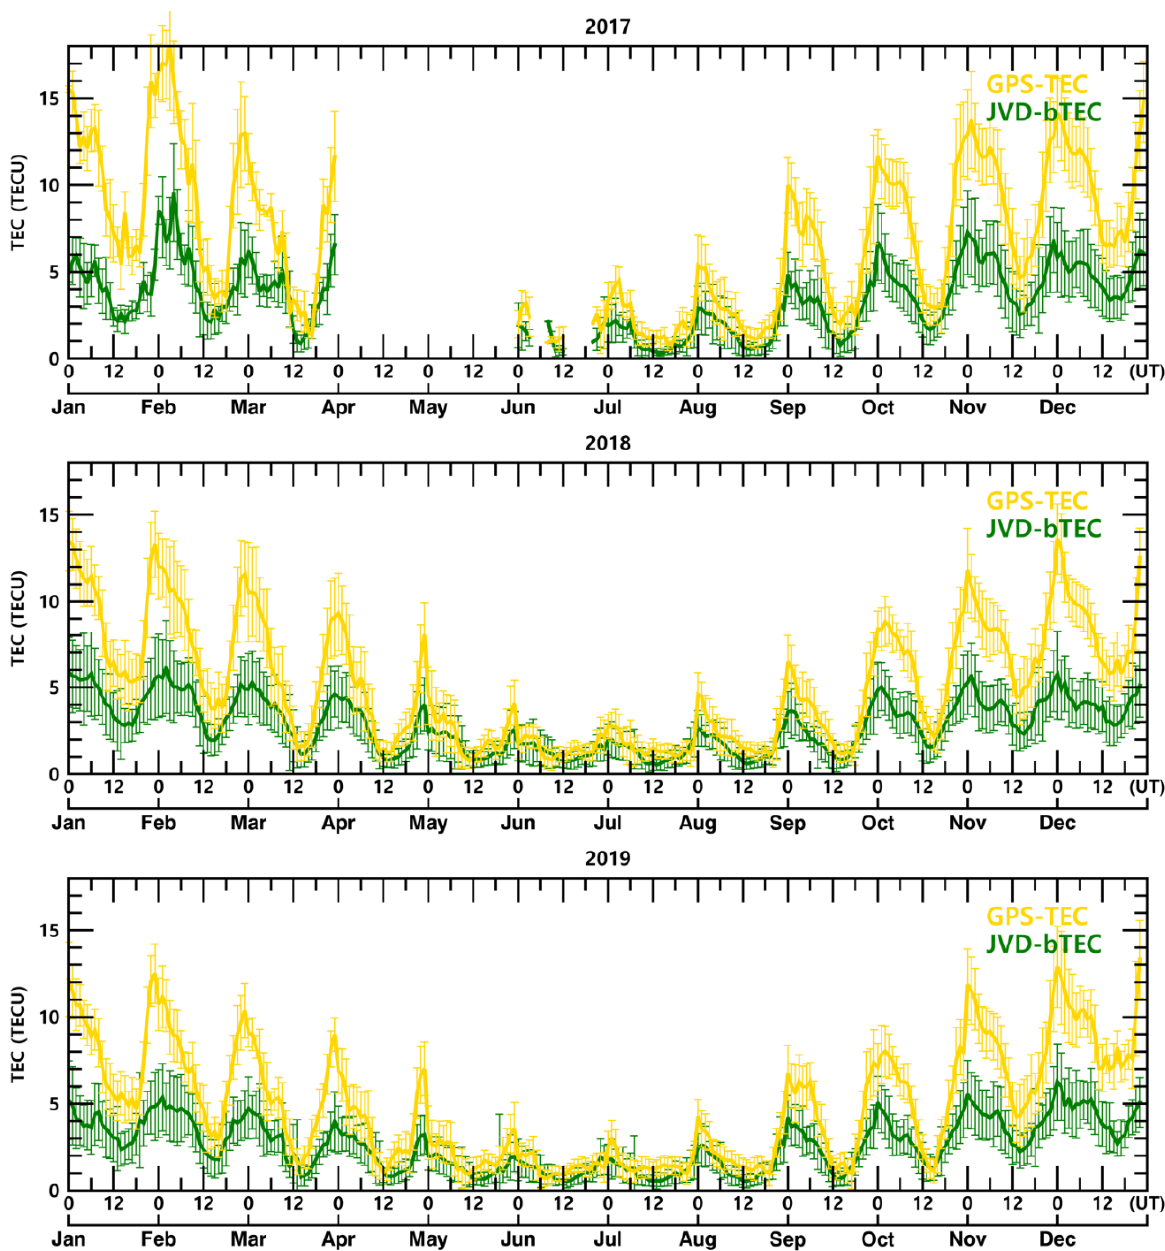
Figure 5. The diurnal variations in mean GPS TEC (yellow) and JVD bTEC (green) from 10 min– averaged values for each month are presented for a three-year period. Note that LT = UT + 11 at JBS.